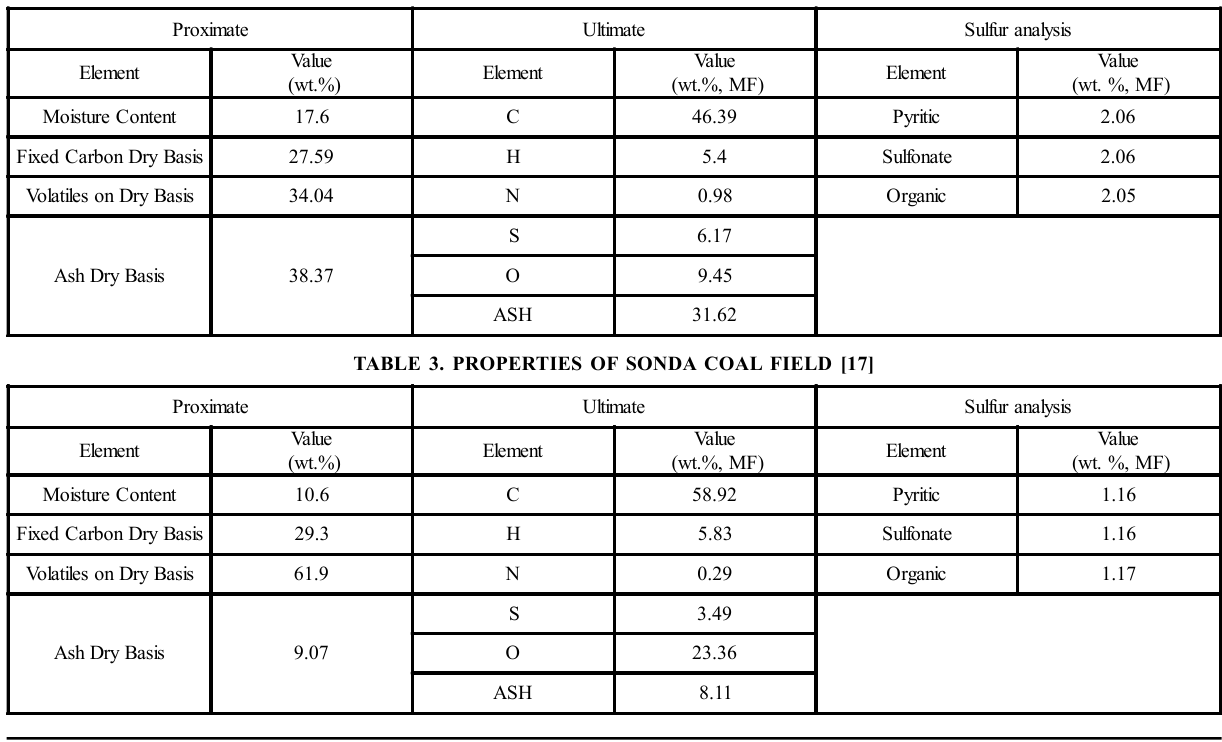
FIG.1. TEXACO DOWN-FLOW SCHEMATIC DIAGRAM OF ENTRAINED FLOW GASIFIER TABLE 2. PROPERTIES OF LAKHRA COAL FIELD [16]